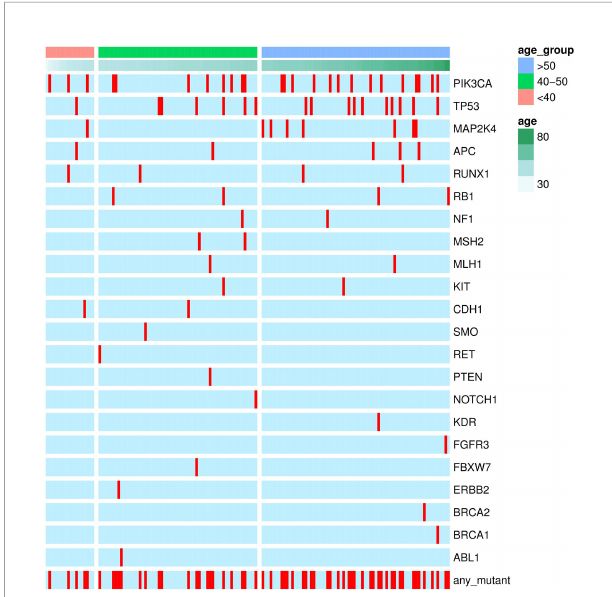
FIGURE 3 | Genetic mutations identi fi ed by the RainDance ™ gene panel in 147 breast cancers. The Oncoprint illustrated the distribution of somatic mutations according to age at diagnosis.